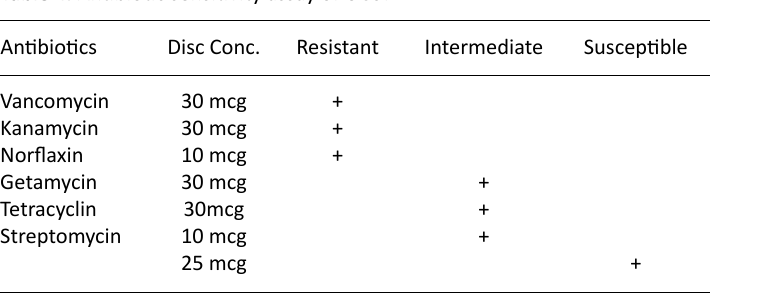
Table 4. Antibiotic sensitivity assay of UC07 Antibiotics Disc Conc. Resistant Intermediate